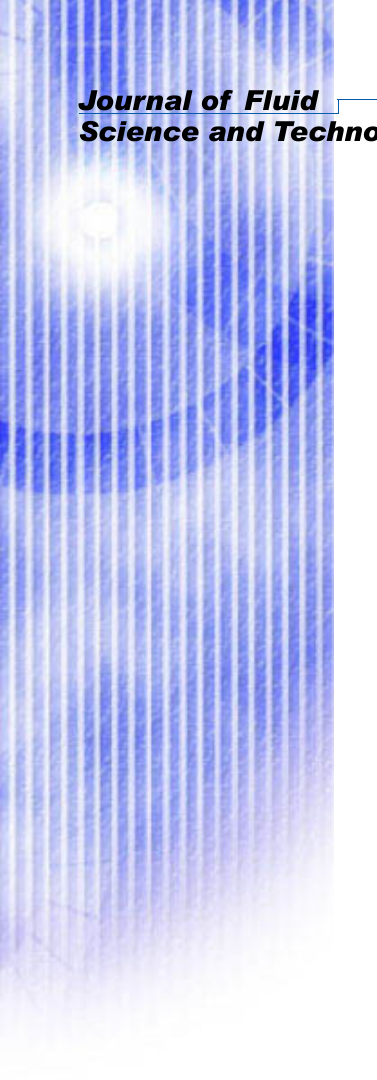
Fig. 3 Distribution of cavitation behaviors on the fluid temperature and the volumetric flow rate The cavitation behavior is classified to three types, as shown in Fig. 3. The first type is a continuous cavitation, which appears stably at the nozzle throat. This type is observed when the temperature is above 76 K. The bubble cloud perpetually oscillates but does not disappear unless the flow condition is purposely reduced. The second type is an intermittent cavitation, which is unstable and disappears after several tens of milliseconds. This type is observed when the temperature is below 73 K. A pulsed pressure oscillation is observed with each occurrence of this cavitation type. The third type is an intermediate cavitation, which exhibits a behavior that is a combination of the continuous cavitation behavior and the intermittent cavitation behavior. This type is observed in the temperature range between 73 K and 76 K. Once cavitation occurs, the bubble cloud acts similarly to a continuous cavitation for several hundreds of milliseconds or more. However, the bubble cloud disappears suddenly without precursor as an intermittent cavitation. Moreover, a strong pulsed pressure oscillation occurs with the occurrence of this cavitation type.